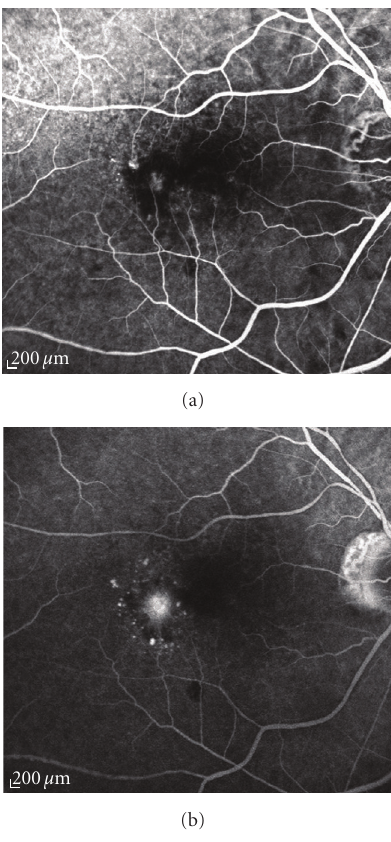
Figure 3: Fluorescein angiography of a minimally classic choroidal neovascularization. (a) Early and (b) late angiograms: the lesion has a mixture of the angiographic features of the classic and occult type, with the classic component making up less than 50% of the entire neovascular complex.